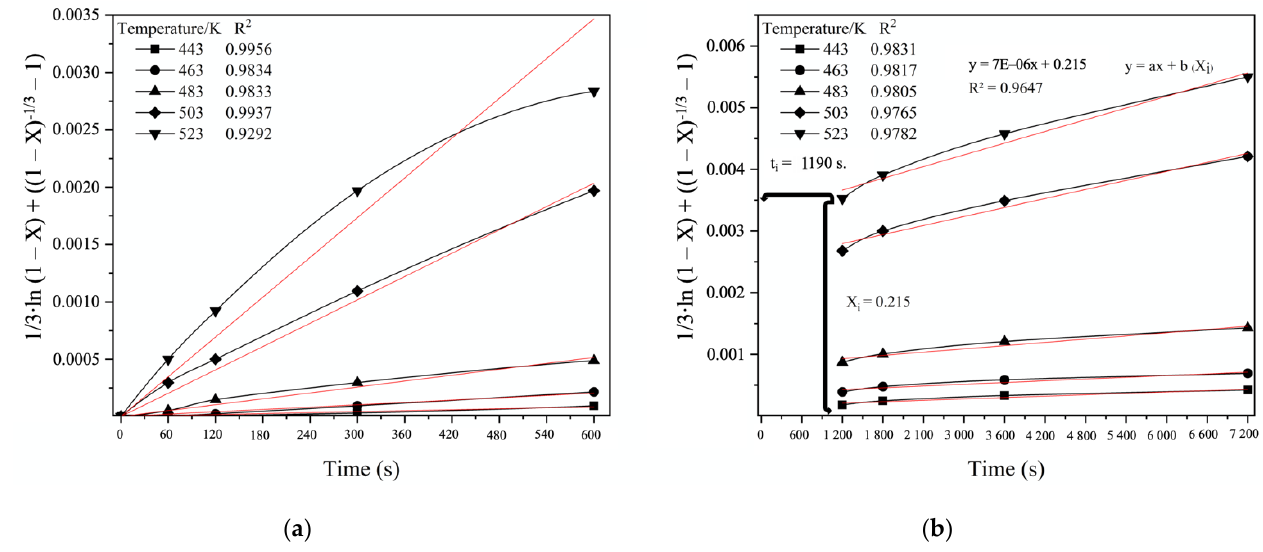
Figure 15. Linear relationship between 1/3 · ln ( 1 − X ) + (( 1 − X ) − 1/3 − 1 ) and hydrothermal treatment time at defined